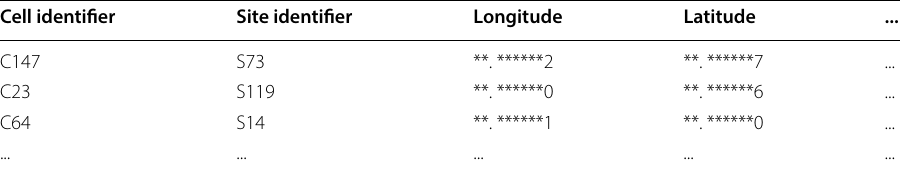
Table 3 Sample of cells and sites